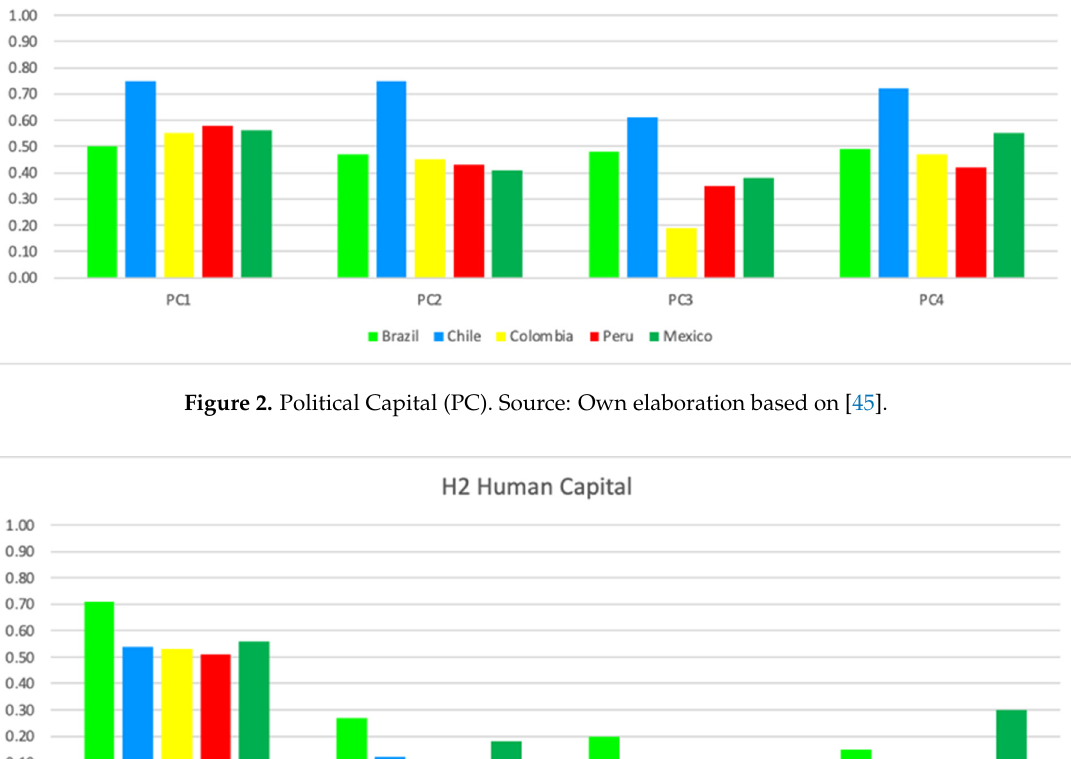
Figure 2. Political Capital (PC). Source: Own elaboration based on [45].